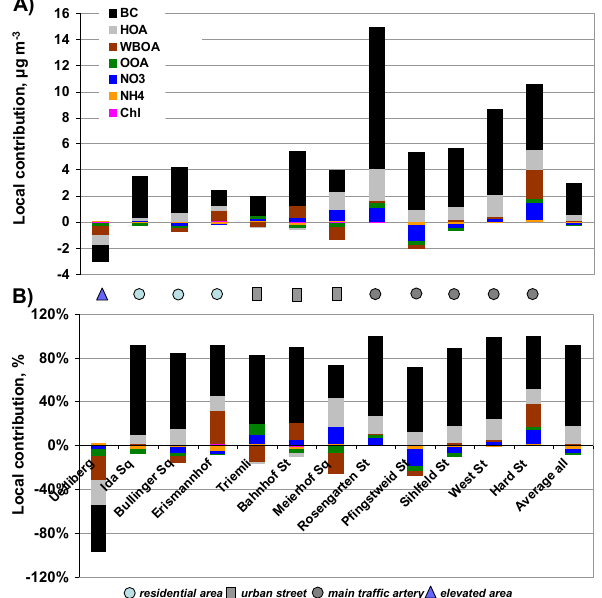
Figure 7: Local contributions of PM 1 components for different sites (absolute values panel A, relative 2 Fig. 7. Local contributions of PM 1 components for different sites values panel B), averages for the whole campaign are shown. The “average all” bar represents the mean 3 (absolute values panel (A) , relative values panel (B) ), averages for value of the local contribution of all data. 4 the whole campaign are shown. The “average all” bar represents the mean value of the local contribution of all data.